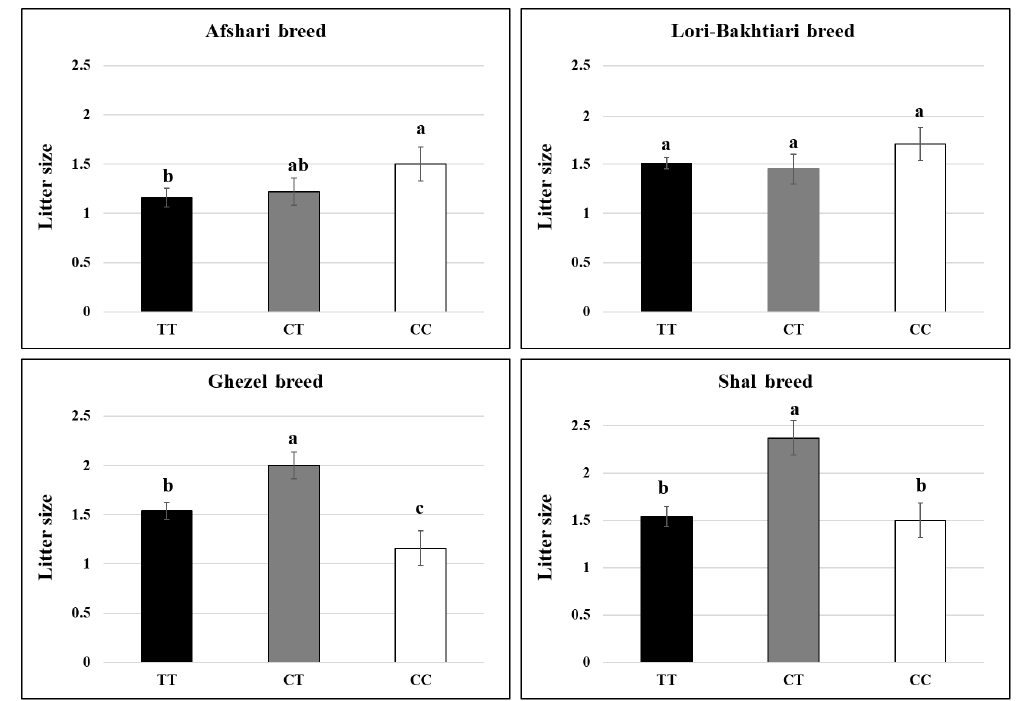
Figure 3. The effect of the T755C genotypes on the ewe litter size in Iranian sheep breeds. T and C are the wild- and mutant-type alleles, respectively. Means with common letters are not significantly different ( P